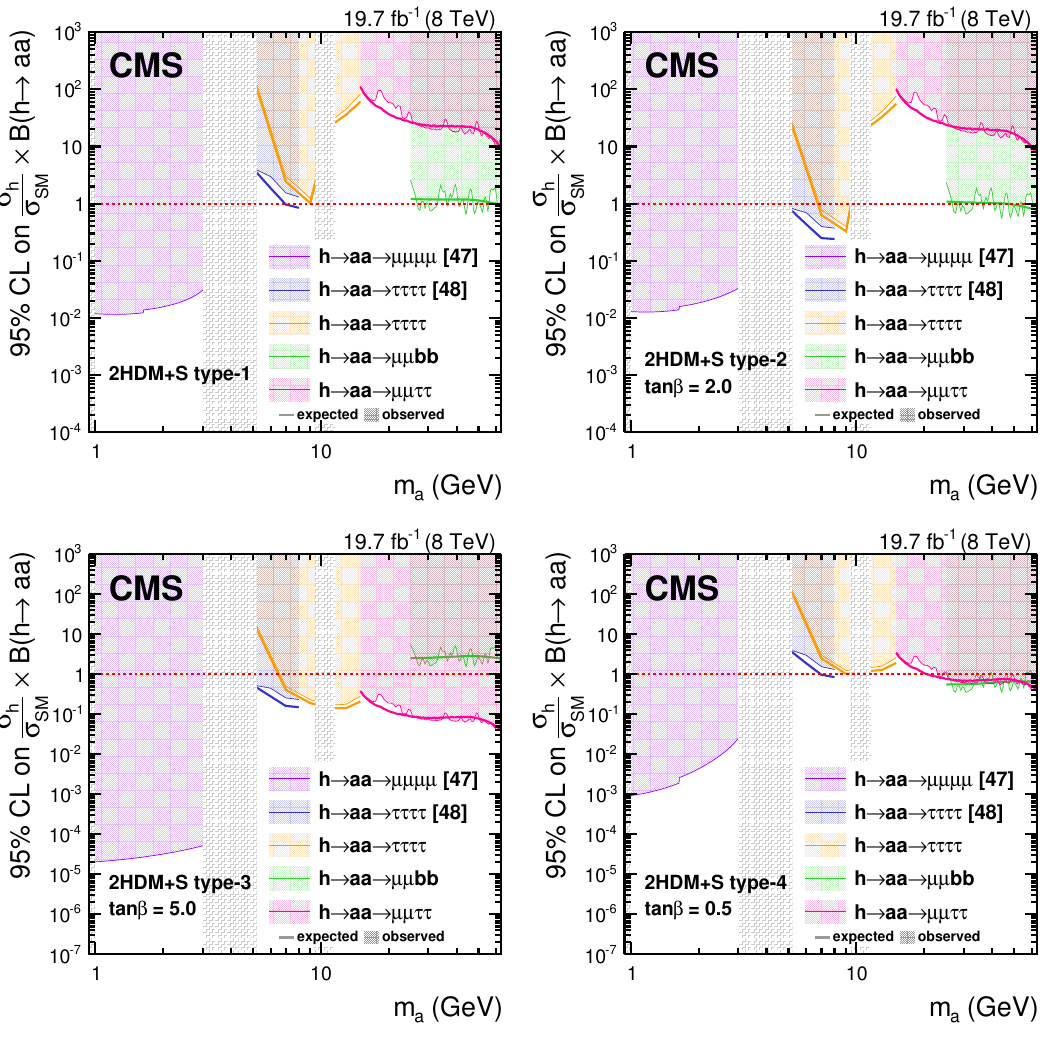
Figure 8 . Expected and observed 95% CL limits on ( (cid:27) h =(cid:27) SM ) B (h ! aa) in 2HDM+S type-1 (top left), type-2 with tan (cid:12) = 2 (top right), type-3 with tan (cid:12) = 5 (bottom left), and type-4 with tan (cid:12) = 0 : 5 (bottom right). Limits are shown as a function of the mass of the light boson, m a . The branching fractions of the pseudoscalar boson to SM particles are computed following a model described in ref. [8]. Grey shaded regions correspond to regions where theoretical predictions for the branching fractions of the pseudoscalar boson to SM particles are not